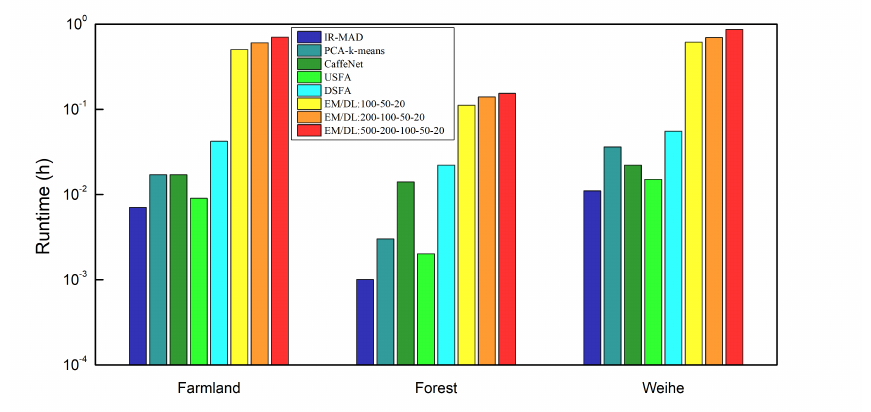
Figure 18. Comparison of runtime of different